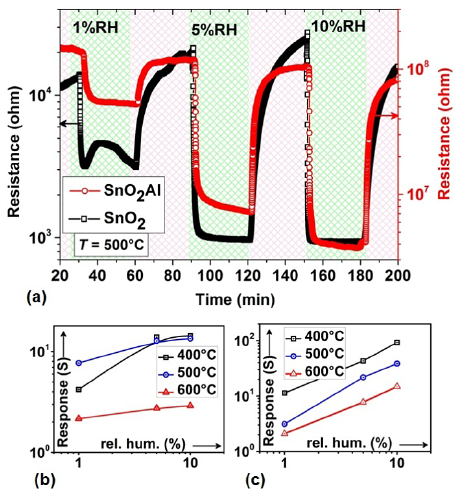
Figure 2. (a) The dynamic responses of SnO 2 ( (cid:3) ) and SnO 2 :Al ( (cid:13) ) layers towards 1–10% RH at T w = 500, (b) response versus relative humidity correlation of SnO 2 and (c) SnO 2 :Al. The response was recorded for a cyclic exposure of 30min to dry and humid